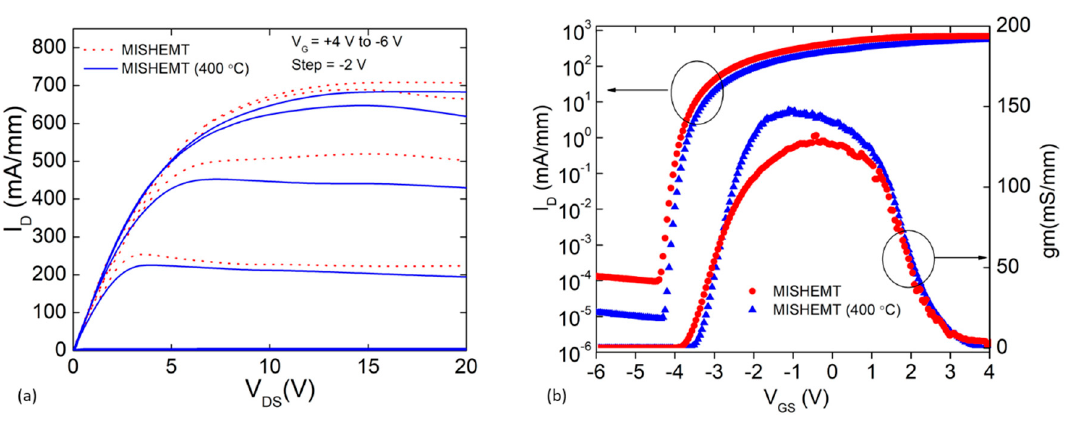
Figure 2. ( a ) DC I DS -V DS and ( b ) transfer characteristics of as-deposited LTE-AlN / AlGaN / GaN MISHEMT and post-gate annealed MISHEMT at 400 °C. Table 2. A benchmarking table for MISHEMT on AlGaN / GaN using AlN as a gate dielectric layer.